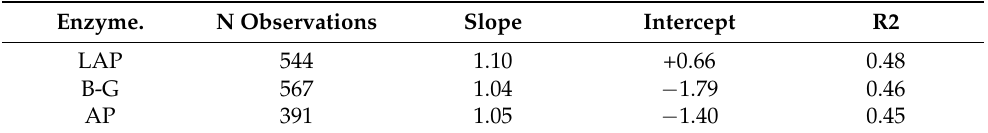
Table 5. Least squares ln-ln regression statistics calculated between HPP and enzyme activities (HPP values ranging from 0.65 to 0.79 µ mol C L − 1 d − 1 , modified from [51]). Enzyme.